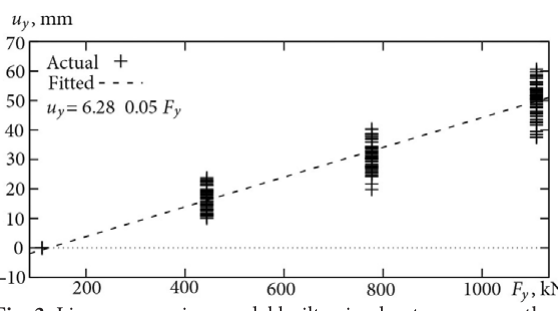
Fig. 3. Linear regression model built using least squares